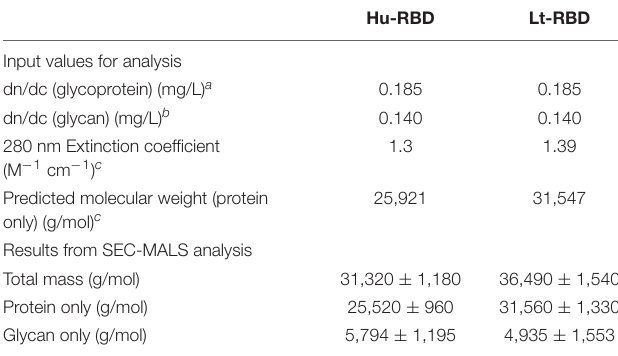
FIGURE 2 | SEC-MALS chromatograms of SARS-CoV-2 RBD produced in HEK293F cells, hu-RBD (blue), and in L. tarentolae , Lt-RBD (red). For each sample, the molar mass values associated with the glycosylated RBD molecules, the protein-only fraction, and the glycan fraction of each peak are shown using dark, intermediate, and light dots, respectively.